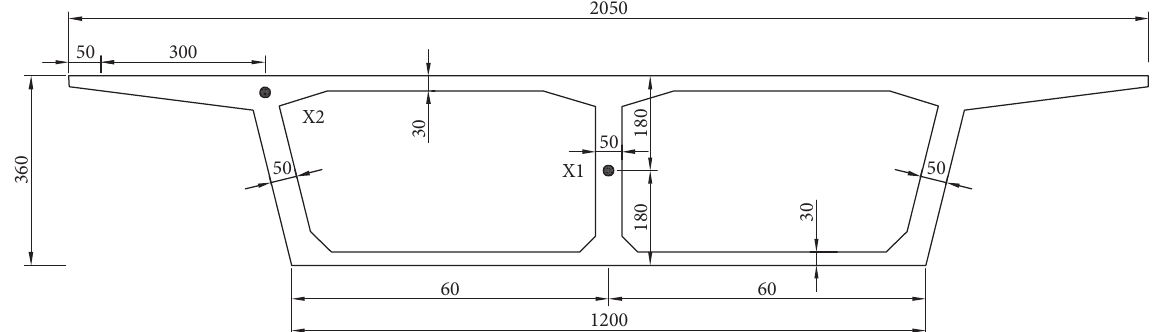
Figure 12: Box girder geometry and measurement point layout (cm).